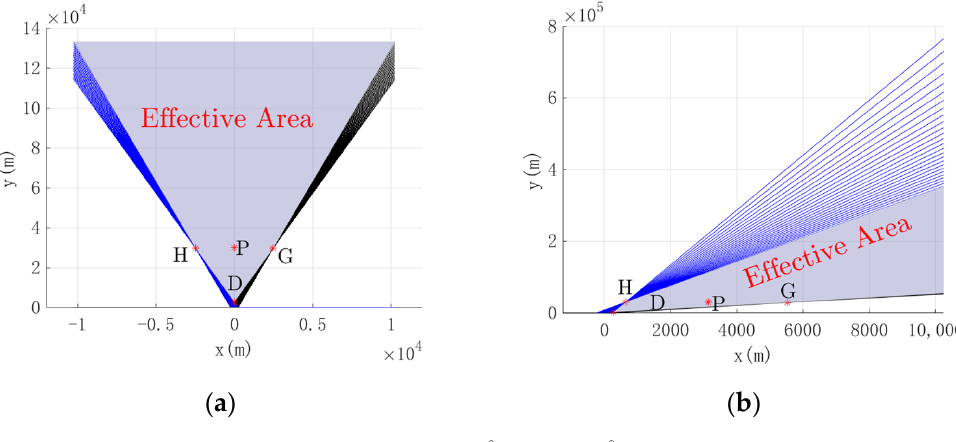
Figure 7. Effectively compensated area. ( a ) θ P = 0 ◦ ; ( b ) θ P = 6 ◦